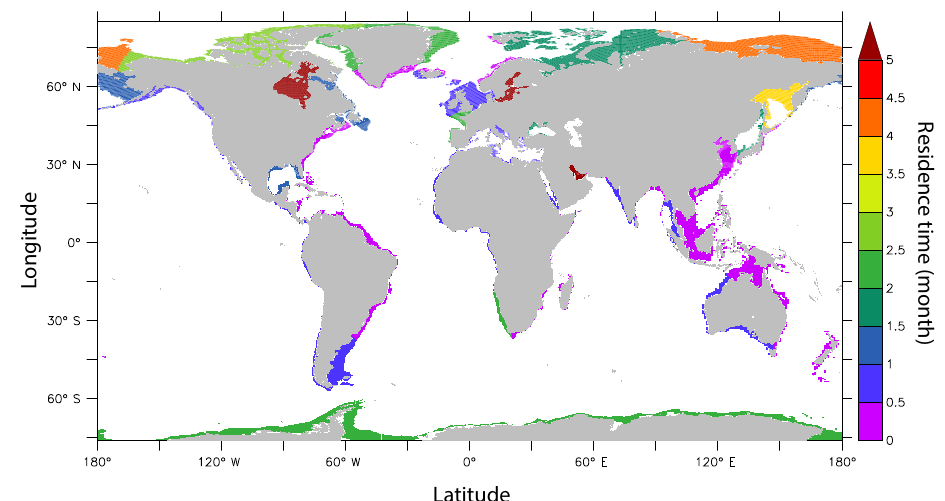
Figure 8. Global distribution of simulated residence time (month) for the global coastal ocean segmented following Laruelle et al. (2013).